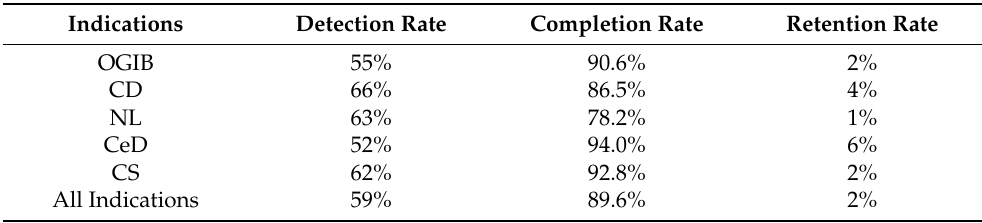
Table 4. Detection, completion and retention rate of capsule endoscopy (all types) according to